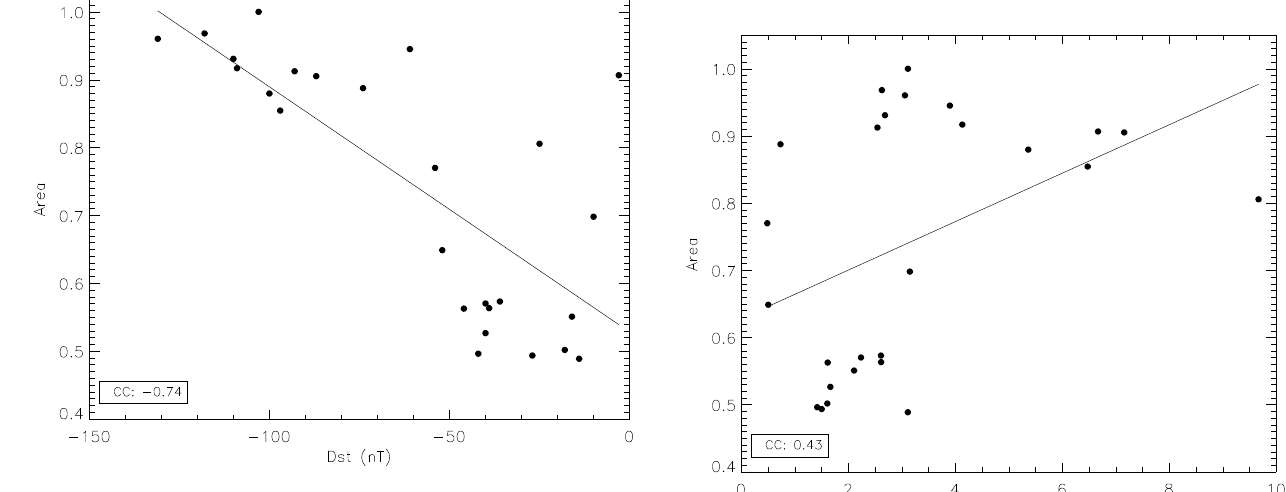
Figure 15. The relationship between the area of CRW and the Dst index during different time of geomagnetic storm on 13 Novem- ber 1998. The y axis has been normalized.